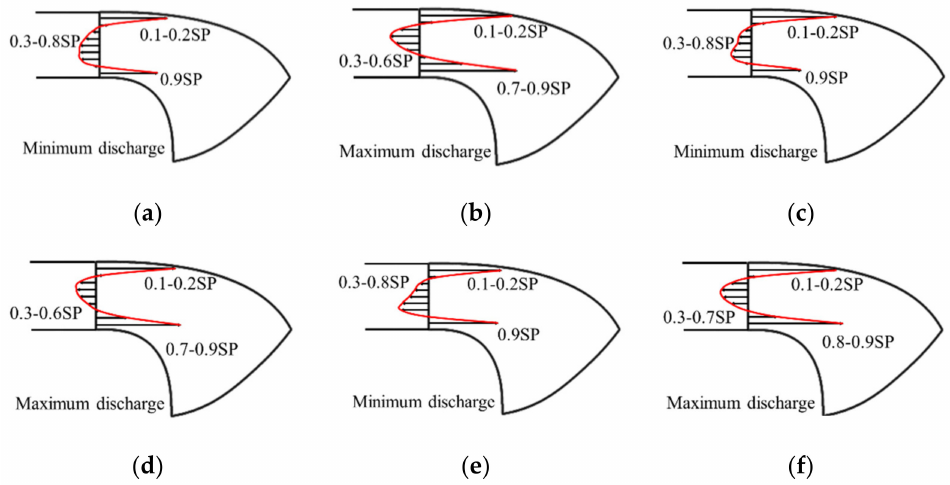
Figure 10. Radial velocity distributions at typical times in Case1. ( a ) t = 31 s; ( b ) t = 39 s; ( c ) t = 47 s; ( d ) t = 54 s; ( e ) t = 63 s; ( f ) t = 71